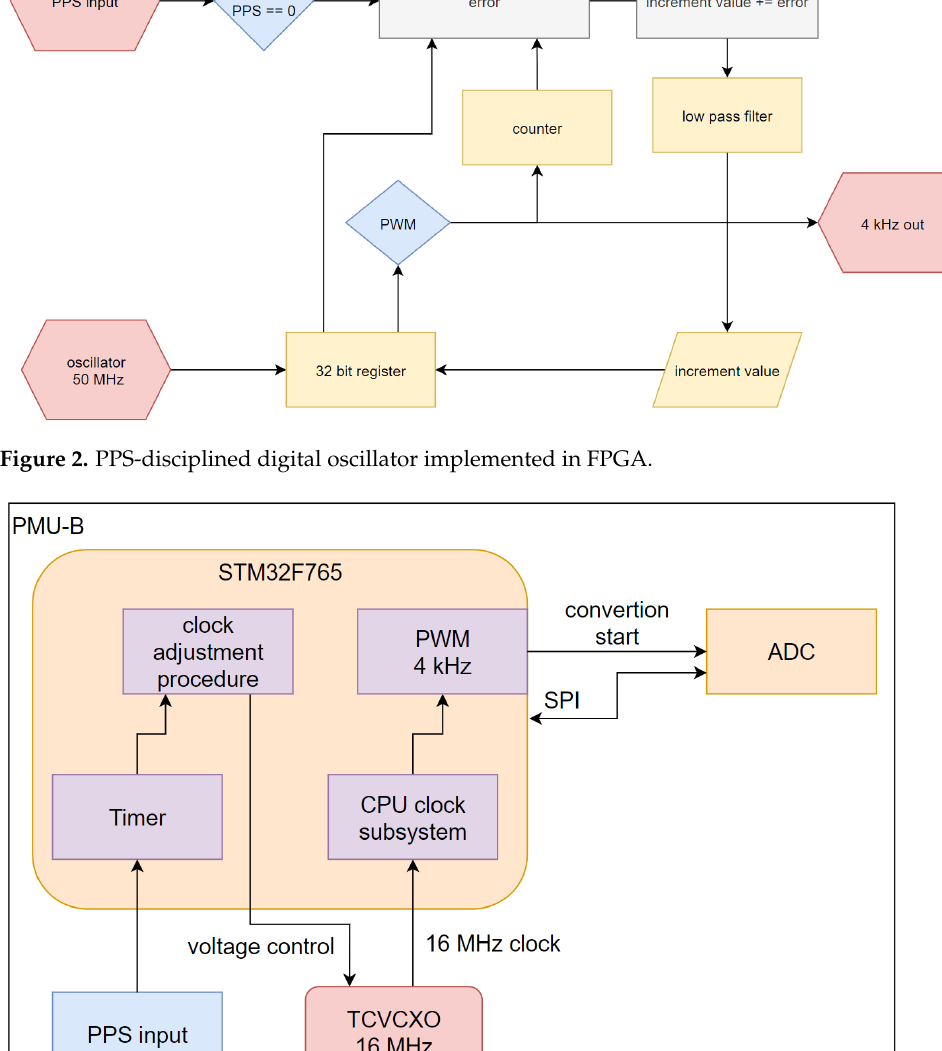
Figure 2. PPS-disciplined digital oscillator implemented in FPGA.